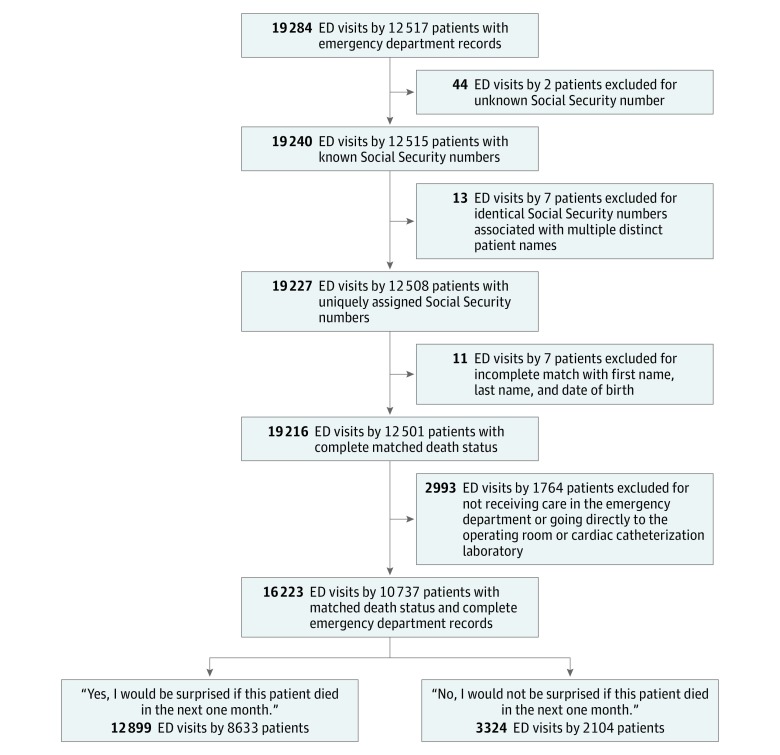
Cohort Selection FlowchartED indicates emergency department.